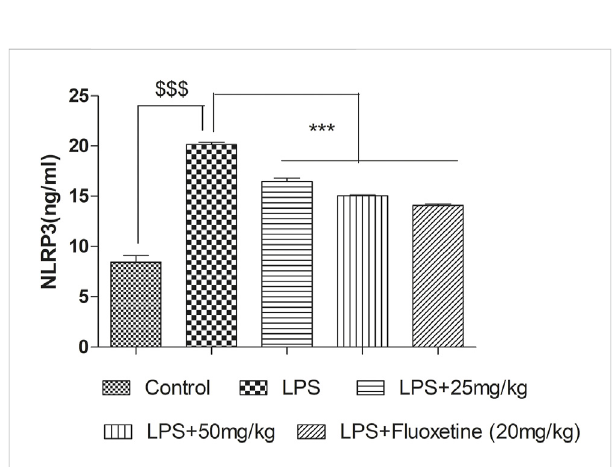
FIGURE 9 Effect of 4-MESC on NLRP3 level evaluated through ELISA